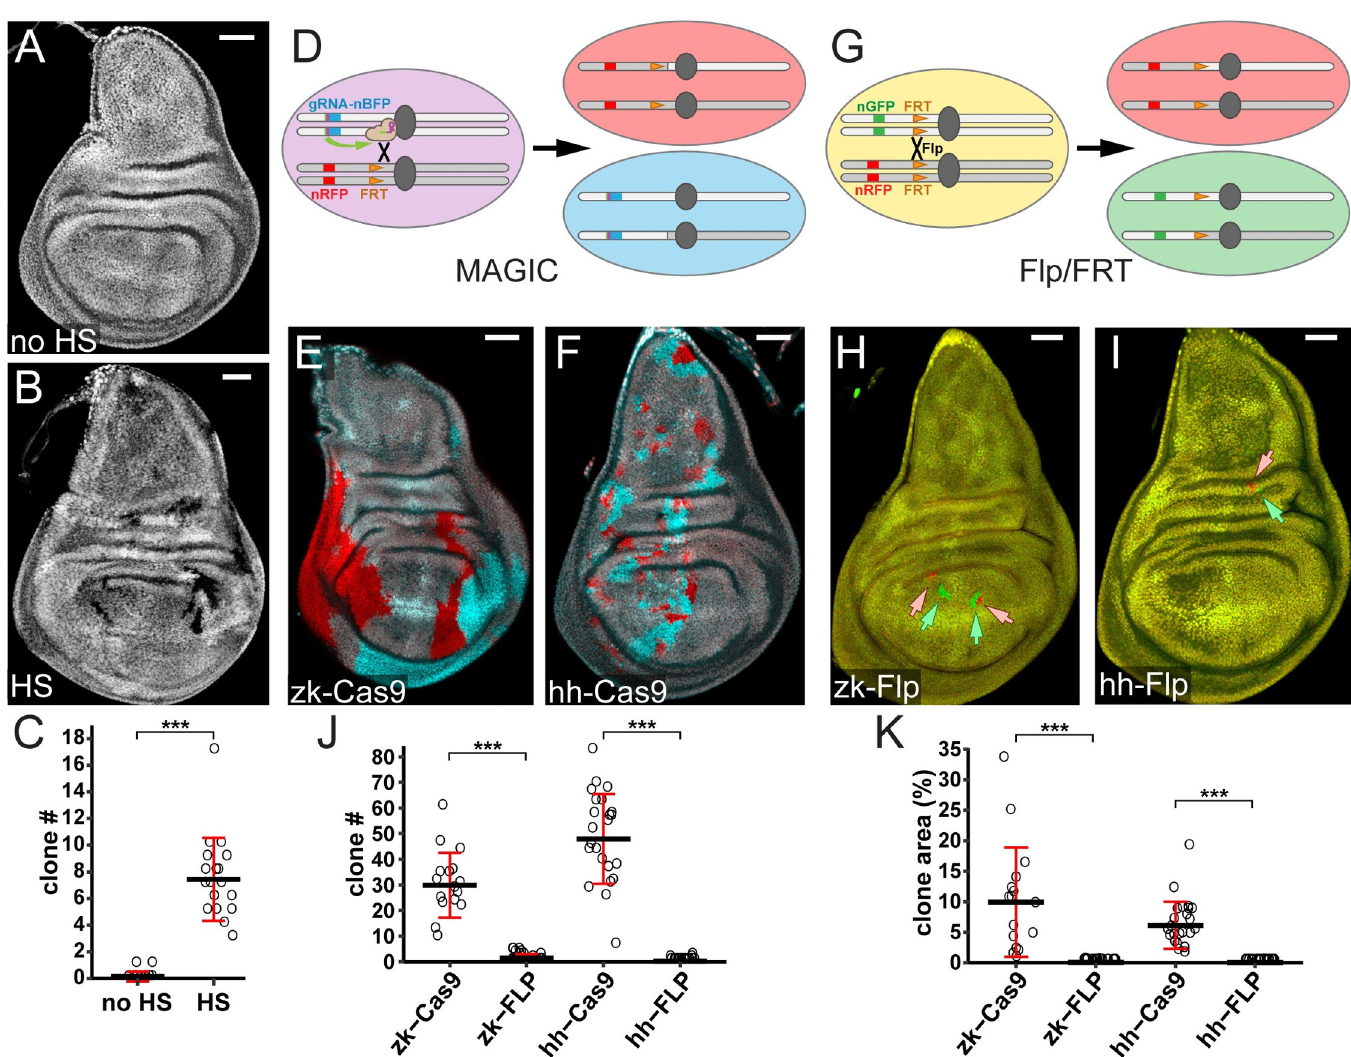
Fig 3. Inducible MAGIC and comparison with Flp/FRT-mediated mosaic analysis. (A and B) Wing imaginal discs of animals with gRNA-40D2(BFP) and HS-Cas9 with (B) and without (A) HS at 72 h at egg laying. (C) Quantification of clone number per disc induced by HS. n = number of discs: no HS ( n = 13), HS ( n = 18). ��� p � 0.001, Welch 2-sample t test. (D) Diagram of twin spot labeling using gRNA-40D2(nBFP) and nRFP FRT 40A chromosomes via MAGIC. (E and F) Wing imaginal discs showing clones generated by MAGIC using zk-Cas9 (E) and hh-Cas9 (F) visualized with nBFP (cyan) and nRFP (red). (G) Diagram of twin spot labeling using nRFP FRT 40A and nGFP FRT 40A chromosomes through Flp/FRT-mediated site-specific recombination. (H and I) Wing imaginal discs showing clones generated by FRT/Flp-mediated site- specific recombination using zk-Flp (H) and hh-Flp (I) and visualized with nGFP (green, indicated by green arrows) and nRFP (red, indicated by pink arrows). (J and K) Quantification of clone number per disc (J) and percentage of total clone area (K). n = number of discs: zk-Cas9 ( n = 16), zk-FLP ( n = 18), hh-Cas9 ( n = 23), hh-FLP ( n = 19). ��� p � 0.001, Welch 2-sample t test. Scale bars, 50 μ m. The data underlying this Figure can be found in S1 Data. Flp, Flippase; FRT, flippase recognition target; gRNA, guide RNA; HS, heat shock; MAGIC, mosaic analysis by gRNA-induced crossing-over; nBFP, nuclear blue fluorescent protein; nGFP, nuclear green fluorescent protein; nRFP, nuclear red fluorescent protein.